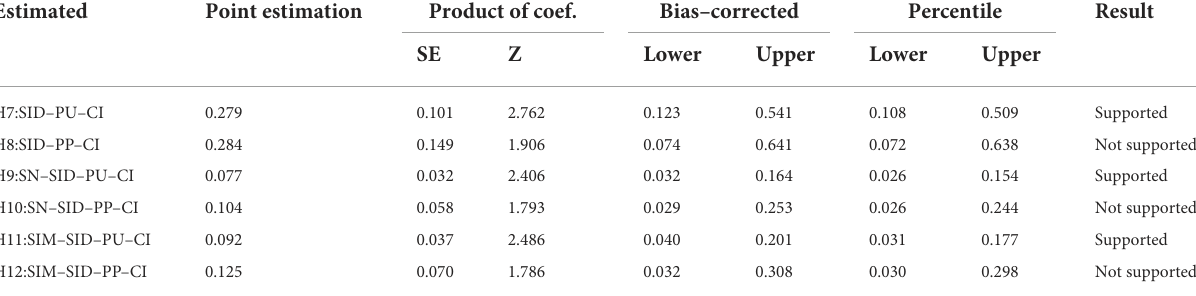
TABLE 7 Mediating effect test